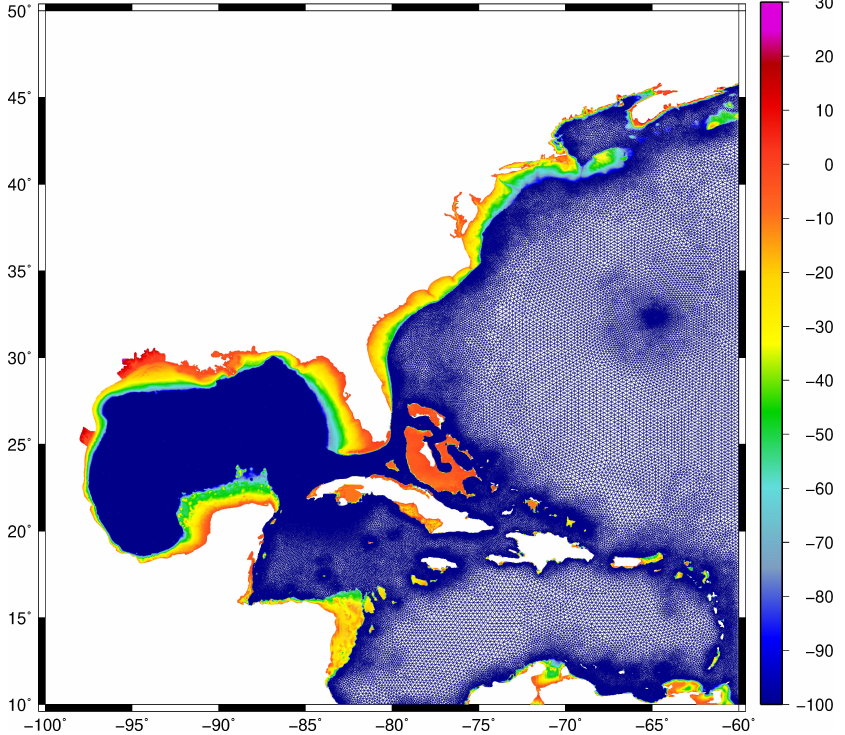
Figure 2. Extent of ADCIRC meshes, the color bar denotes bathymetric depth (cut off at 100 m for the sake of